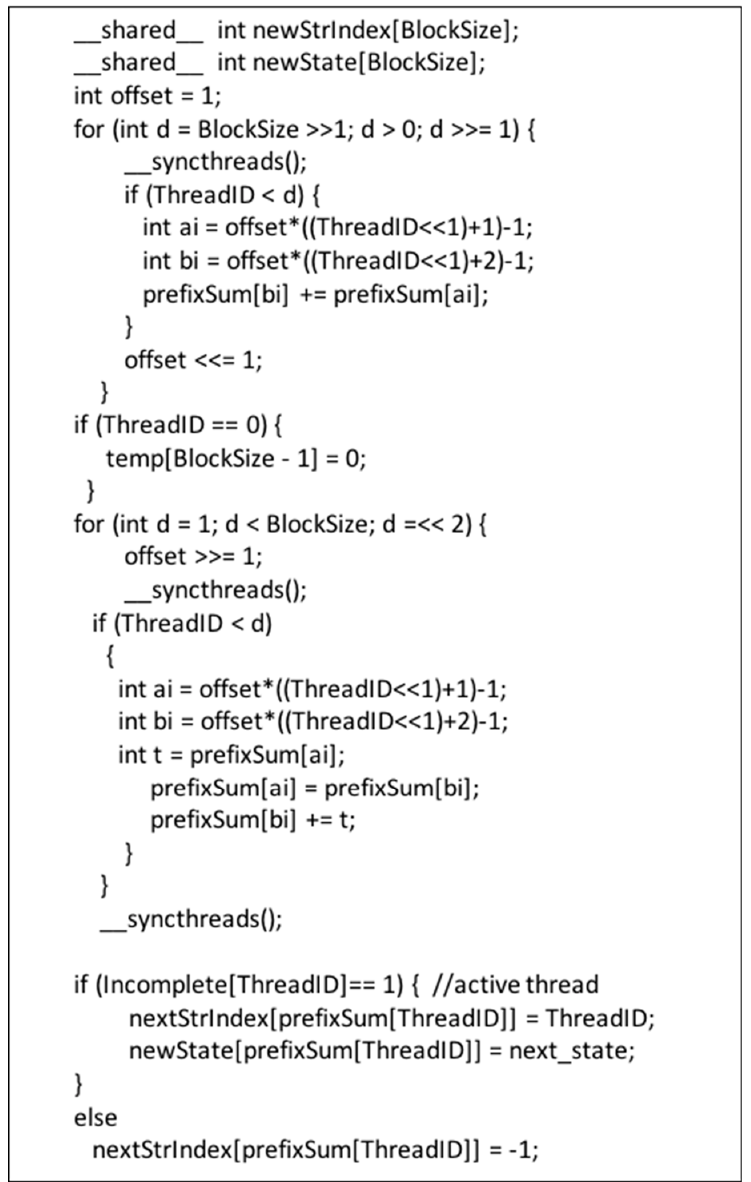
Figure 7. Phase one of the two-phase PFAC algorithm: Job compression procedure.